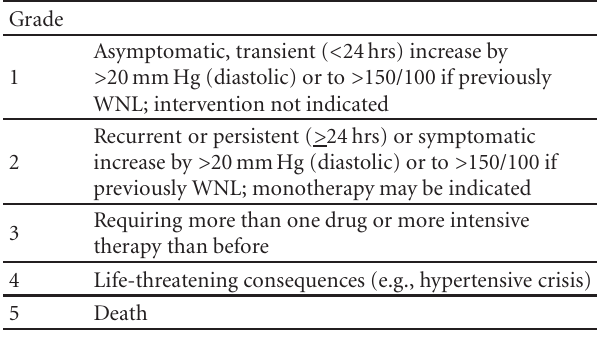
Table 2: Common terminology criteria for adverse events v3.0 (CTCAE): hypertension